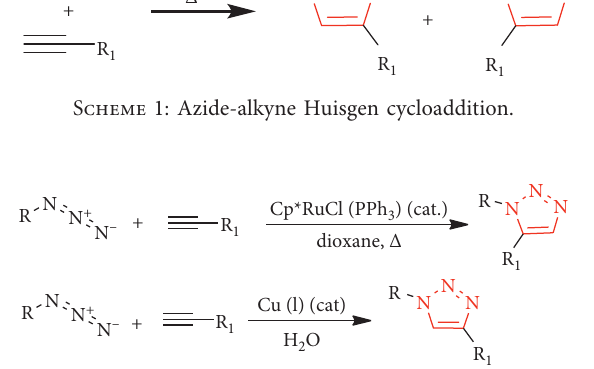
Scheme 2: Copper-catalyzed and ruthenium-catalyzed reaction on